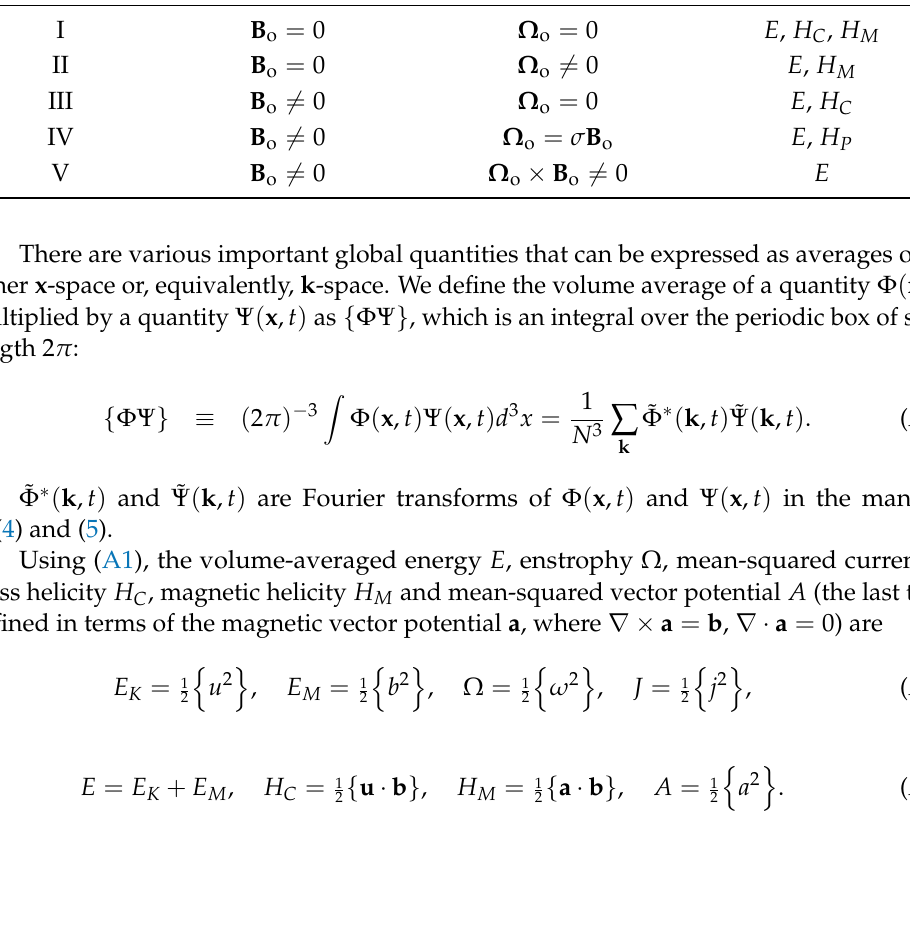
Table A1. Integral invariants for ideal MHD turbulence. The ‘parallel helicity’ of Case IV is H P = H C σ H M and occurs when Ω o = σ B o , i.e., Ω o is parallel to B o . − Case Mean Field Rotation